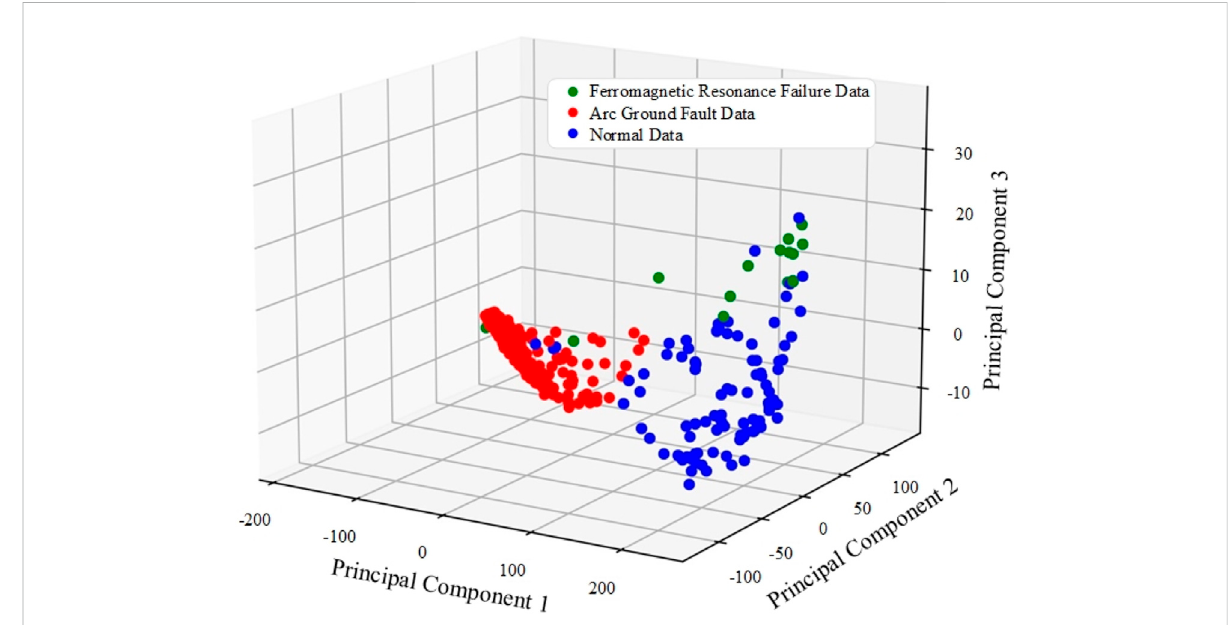
FIGURE 5 Distribution map of arc grounding, ferromagnetic resonance, and normal conditions.